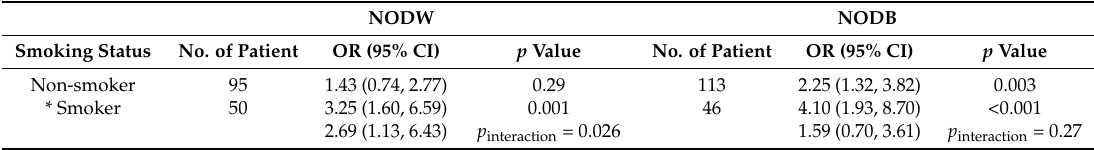
Table 3. The association between triglycerides (TG) and NODW, NODB stratified by smoking status that modified the TG–NODW and TG–NODB association. NODW